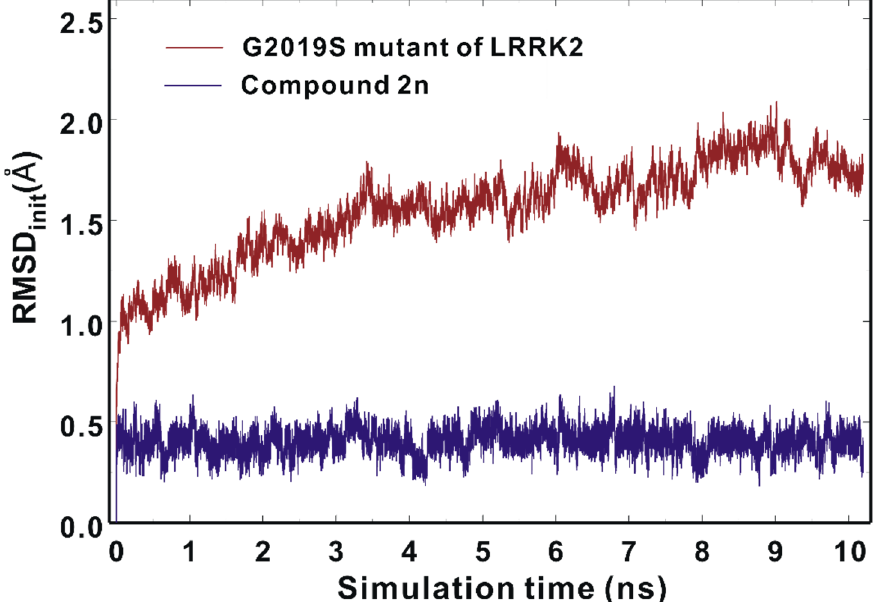
Figure 9. Time evolutions of the root-mean-square deviation (RMSD init ) of the backbone C α atoms of the G2019S mutant (brown) and those of the heavy atoms of Inhibitor 2n (blue).